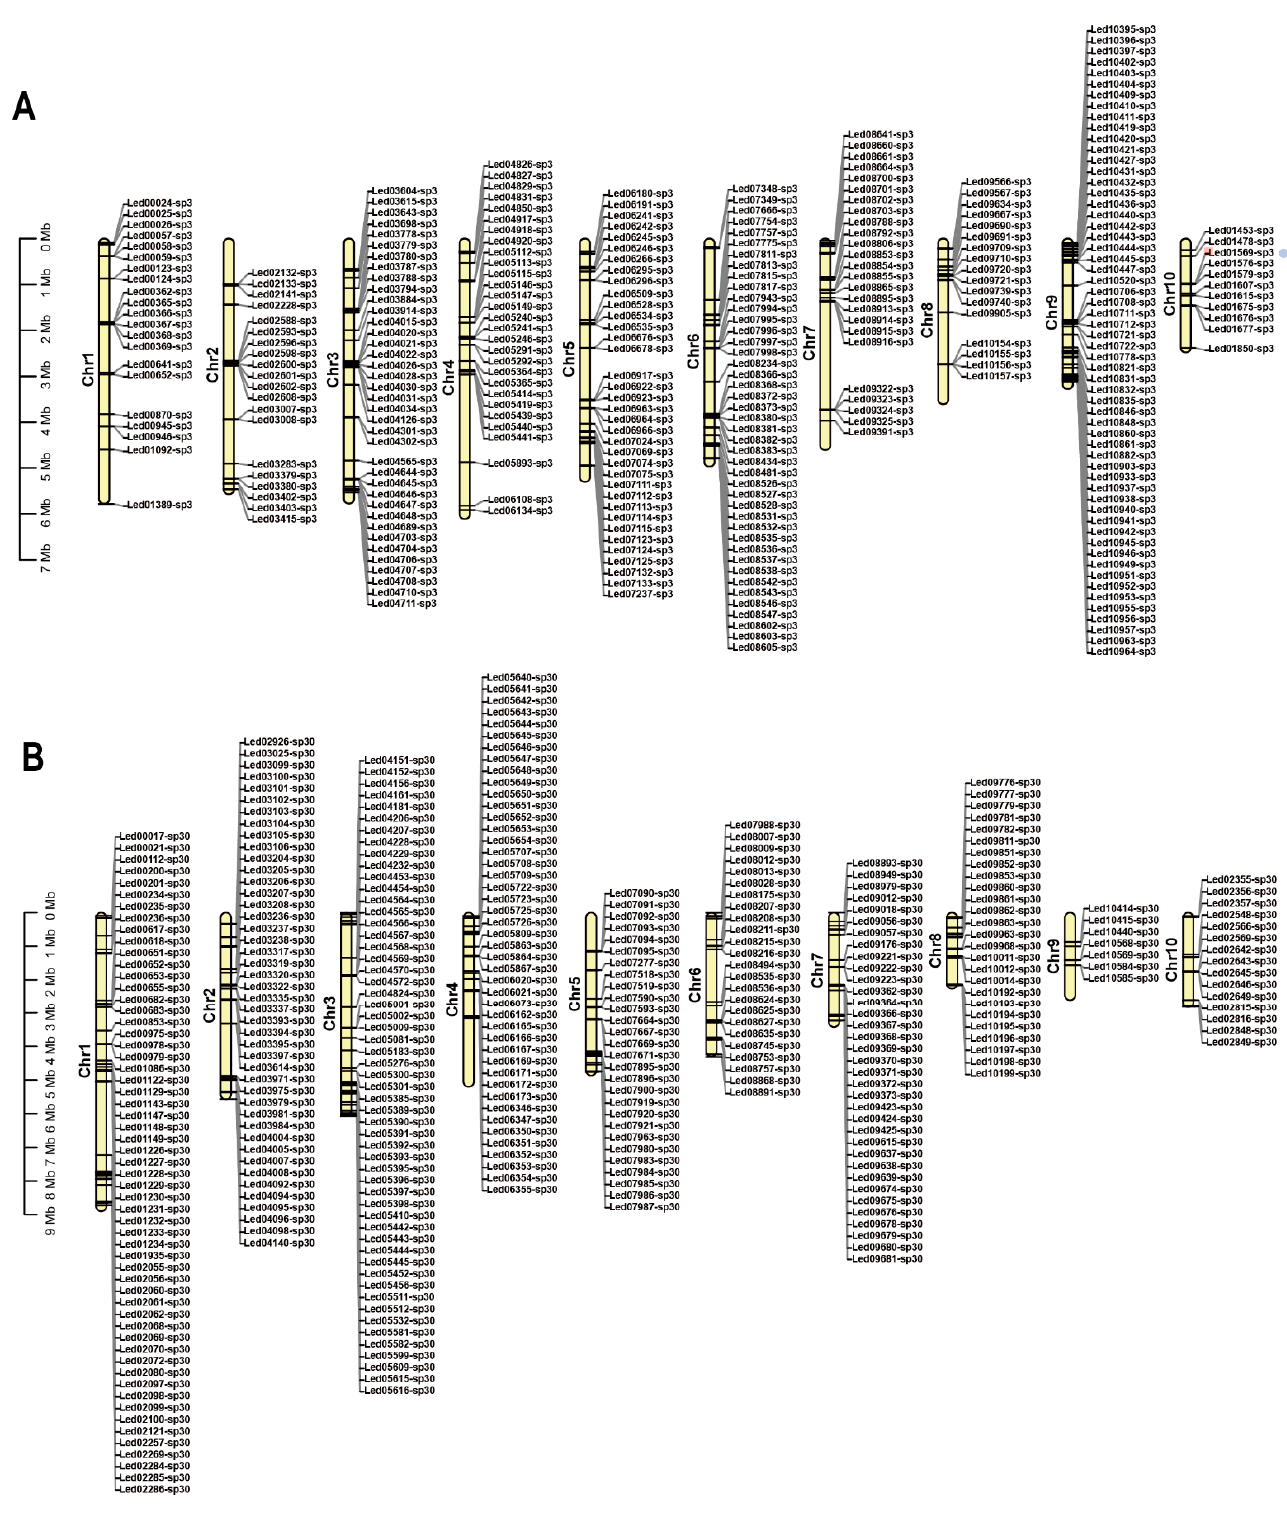
Commented [M3]: Please replace Figure 5 with the picture above